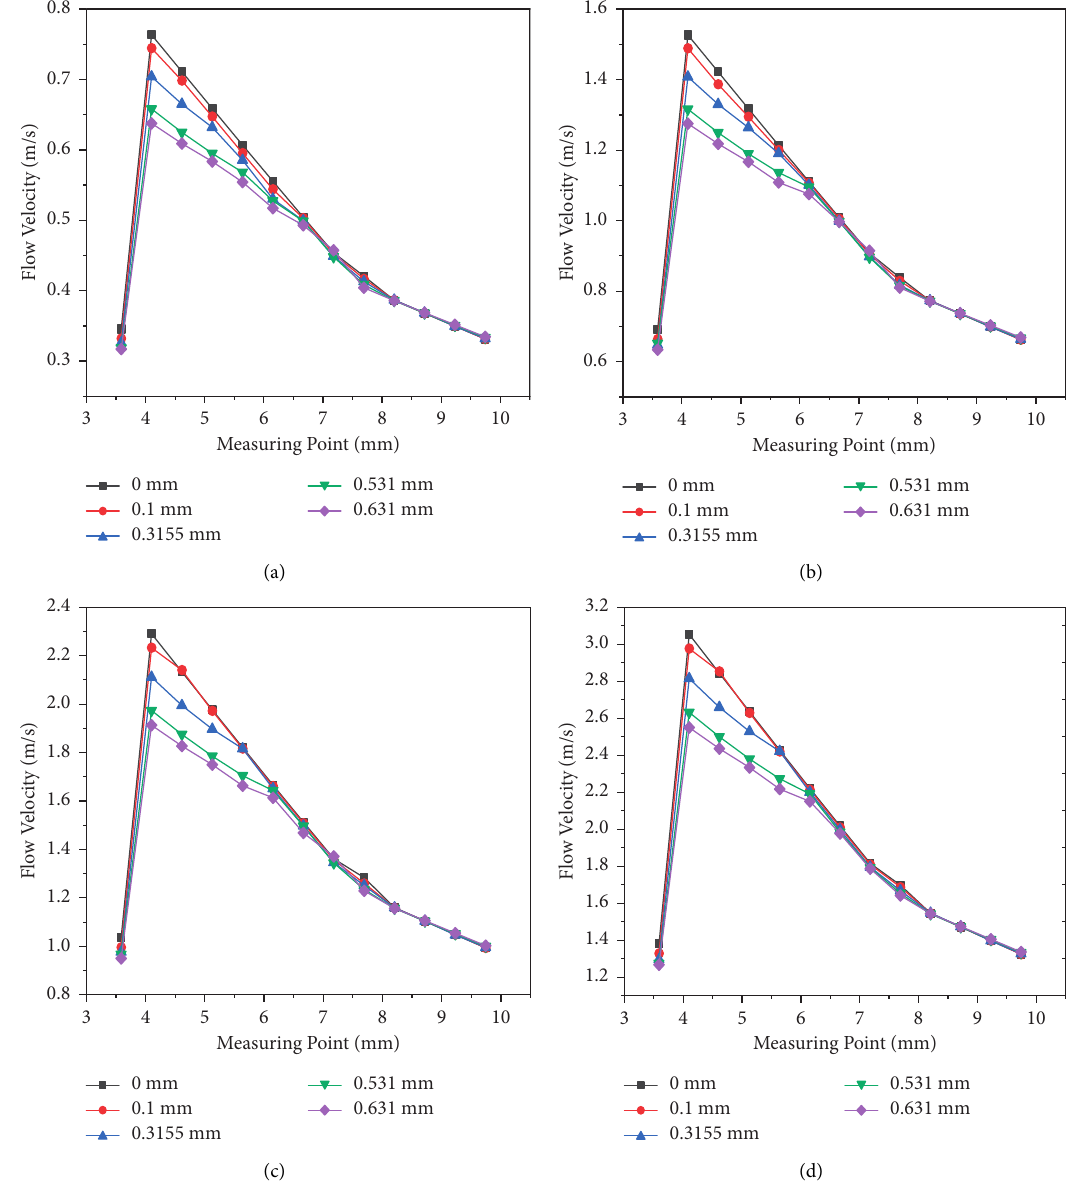
Figure 12: The curve of velocity variation along the aperture direction of fracture under different hydraulic pressure rates. (a) 0.2MPa, (b) 0.4 MPa, (c) 0.6MPa, and (d)